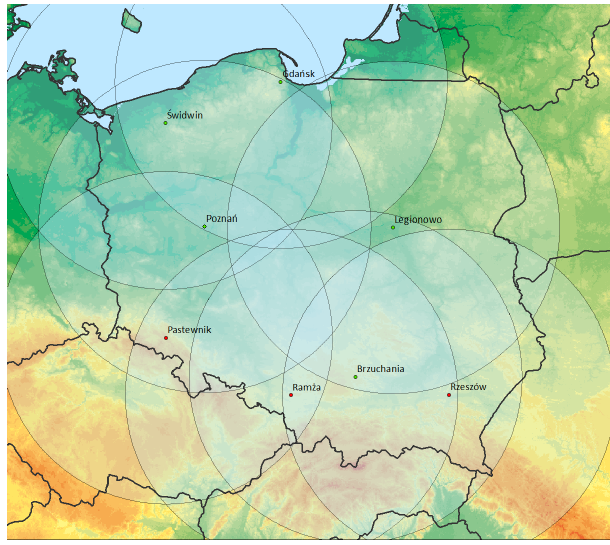
Figure 1. Coverage of the area of Poland by weather radar net- work POLRAD with 250km range as of 2021. Polarimetric radars marked in red. Table 1. Parameters and scan strategy for radar reflectivity scans used in weather radars of the POLRAD